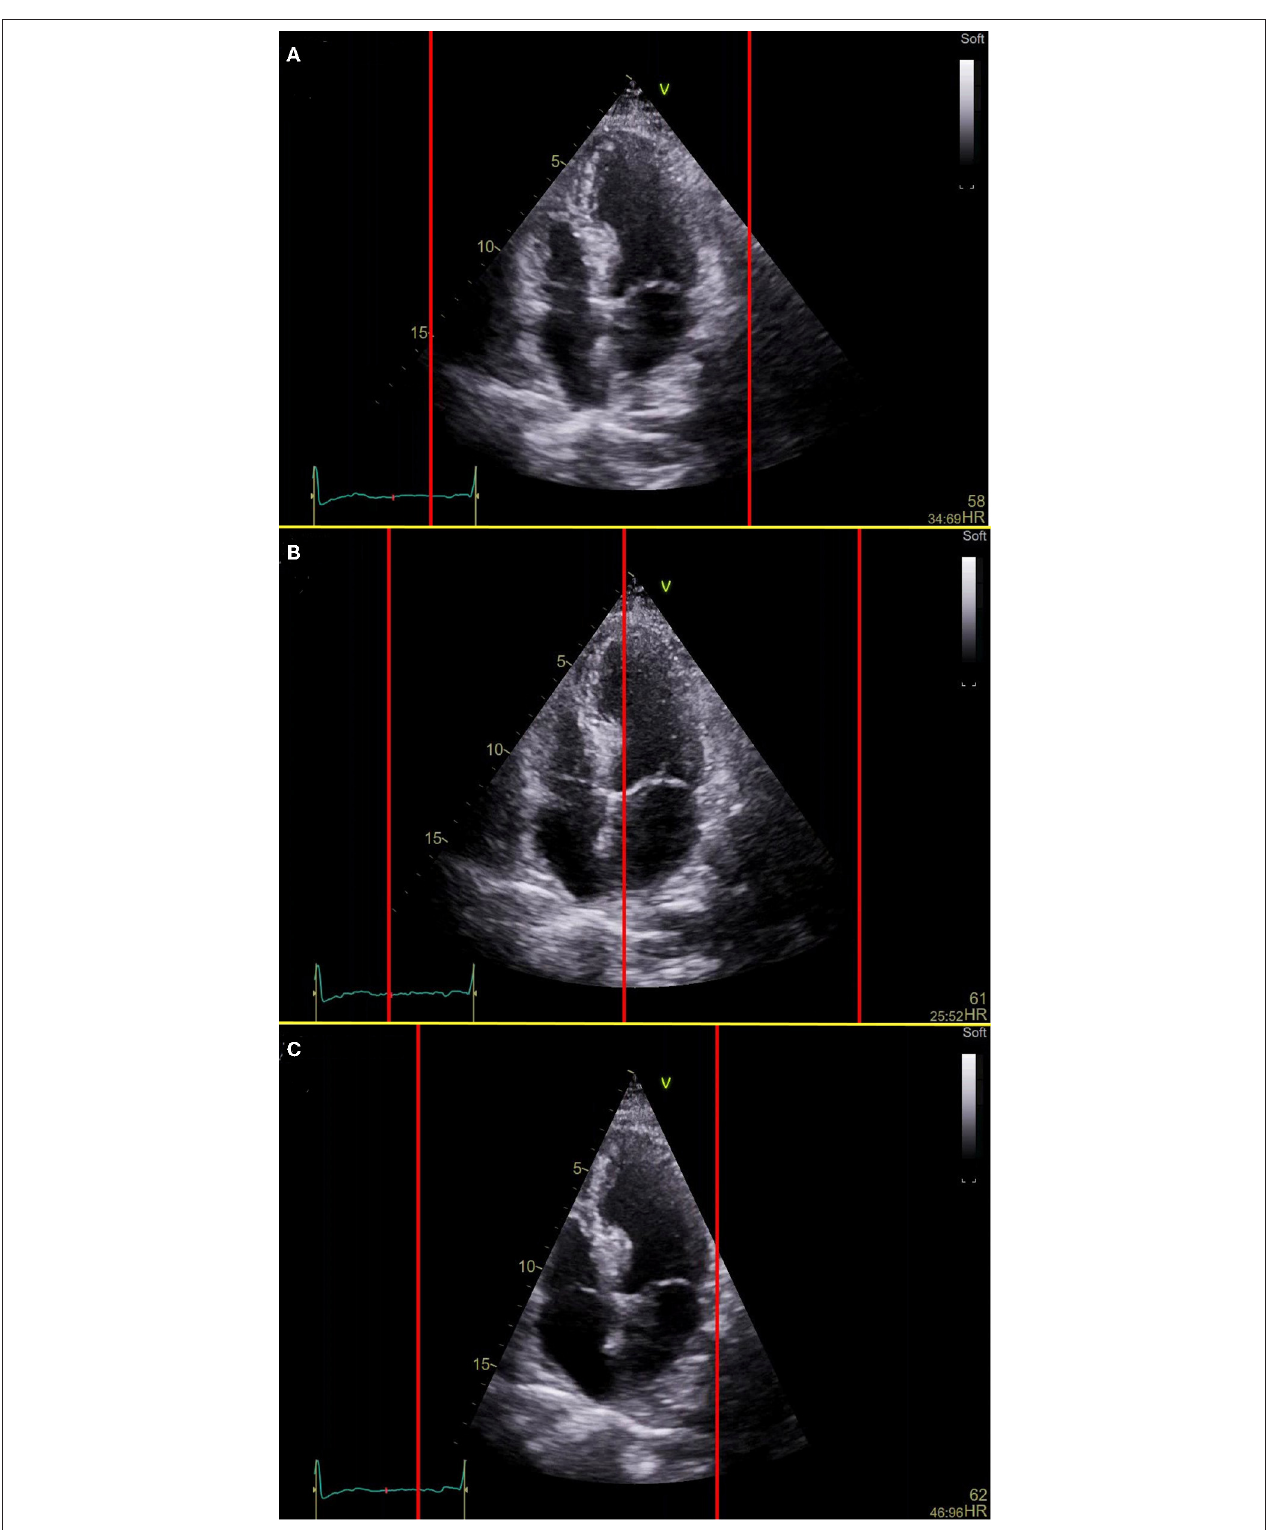
FIGURE 2 | Viewing of the video with different frame rates on the monitor with a fixed refresh rate (60Hz). (A) The frame rate of the video and refresh rate of the monitor is the same. Background video, the apical 4-chamber view has a frame rate of 60fps, vertical red lines move with a constant speed from frame to frame, in this case,60 fps. There is an “agreement” between our eyes, red lines, and 4-chamber view. This video is easy for observation and perception. (B) The frame rate